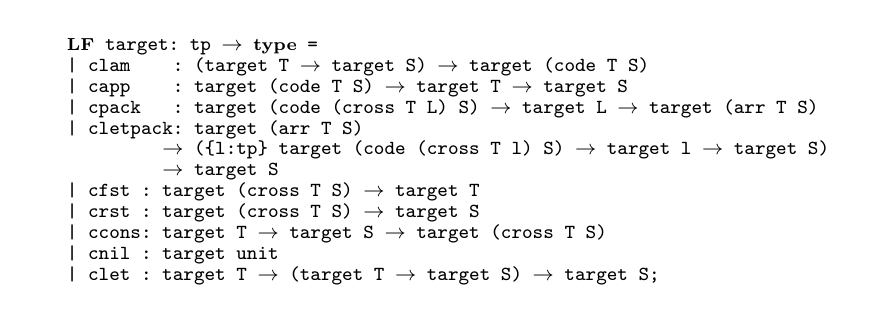
Fig. 11. Encoding of the Target Language of Closure Conversion in